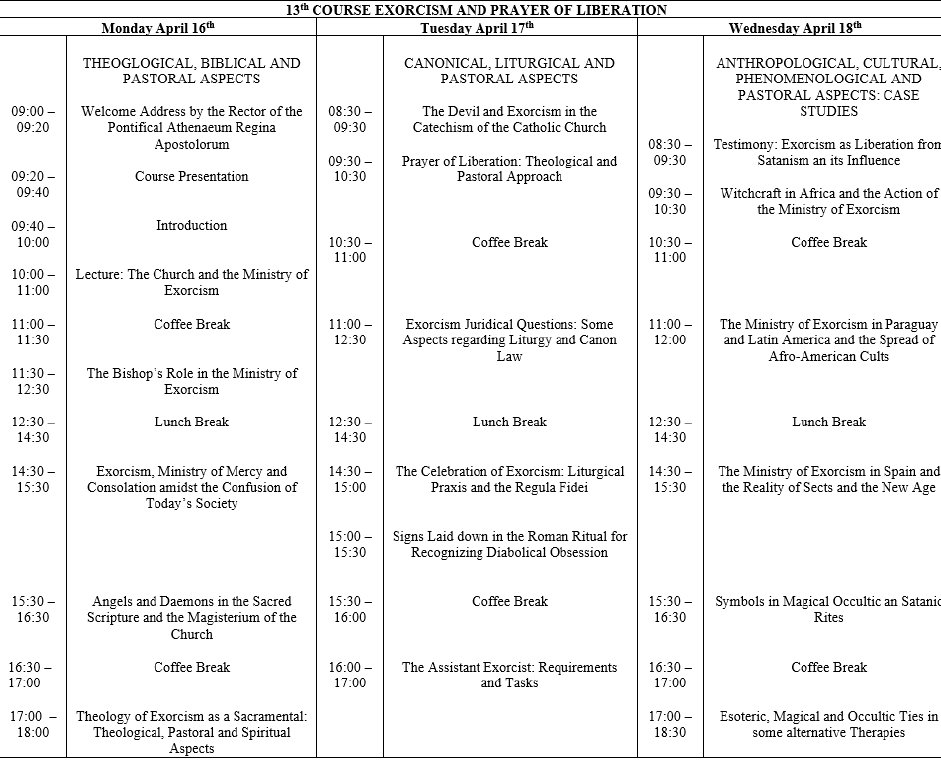
Figure 1. Program of the 13th Course on Exorcism and Prayer of Liberation. 6. Conclusions In Roman Catholic exorcism discourses, demons represent, to adopt a medical term, the “viruses” that make people “spiritually” ill. The exorcists operate within a social and